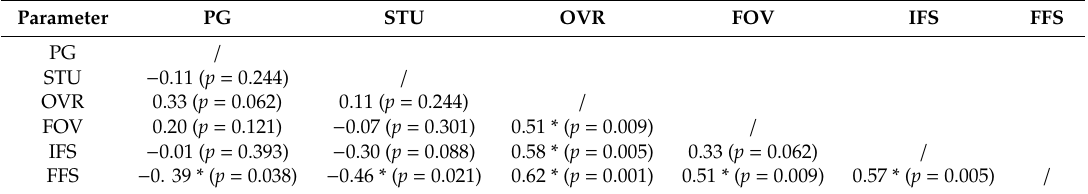
Table 1. Pearson’s coe ffi cient of linear correlation between the reproductive